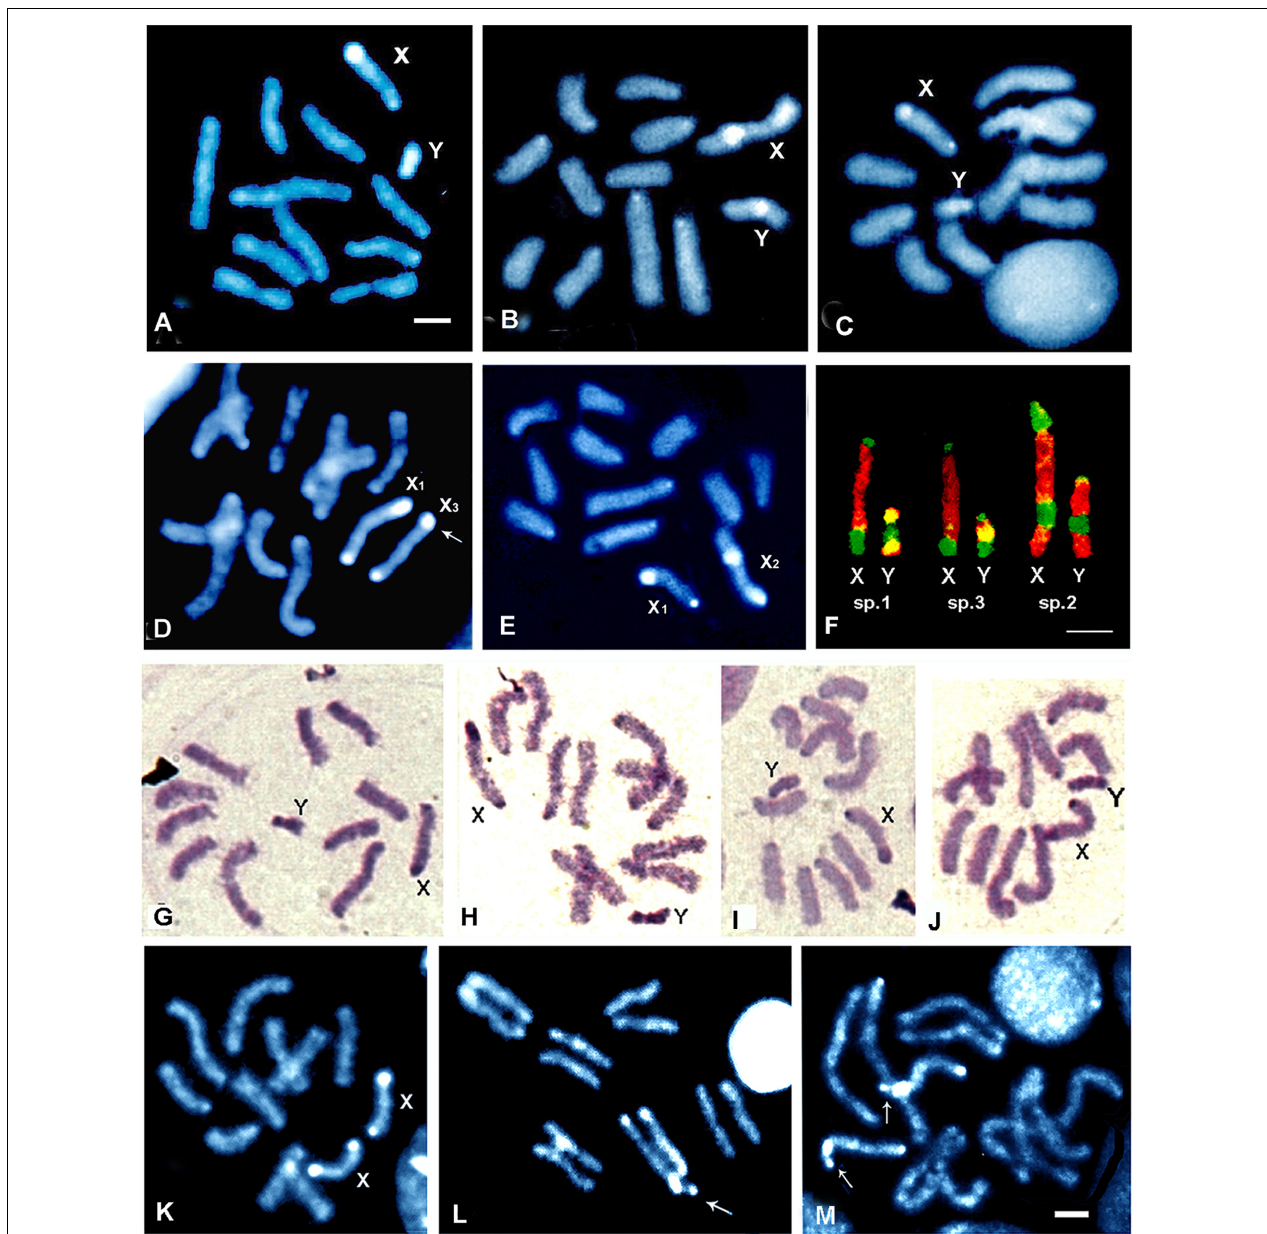
FIGURE 1 | Karyotypes of A . sp.1 (A) , A . sp.2 (B) , and A . sp.3 (C) stained by DAPI. Note the heterochromatic blocks in the sex chromosomes; (D,E) Chromosomes of hybrid females obtained in laboratory and stained by DAPI. The arrow in (D) indicate the difference in size of the distal heterochromatic blocks of X 1 and X 3 . (F) Chromosomes are stained sequentially by CMA3 and DAPI. Note the difference between the Y chromosomes of A. sp.1 and A . sp.3 in relation to the heterochromatin blocks (green, AT reach; yellowish, rich in AT + GC) and the larger size of the chromosomes of A . sp.2; (G–J) C-banded mitotic chromosomes of a A . sp.1 male showing the distinct structural configurations of the heterochromatic blocks of the Y chromosome; (K–M) The three genetic forms for the variant X chromosome in A . sp.1 females, (K) standard homozygous, (L) heterozygous, and (M) homozygous for the variant X. The variant X possess a larger distal heterochromatic block which is divided by a secondary constriction (arrows). Scale bar = 10 µ m.